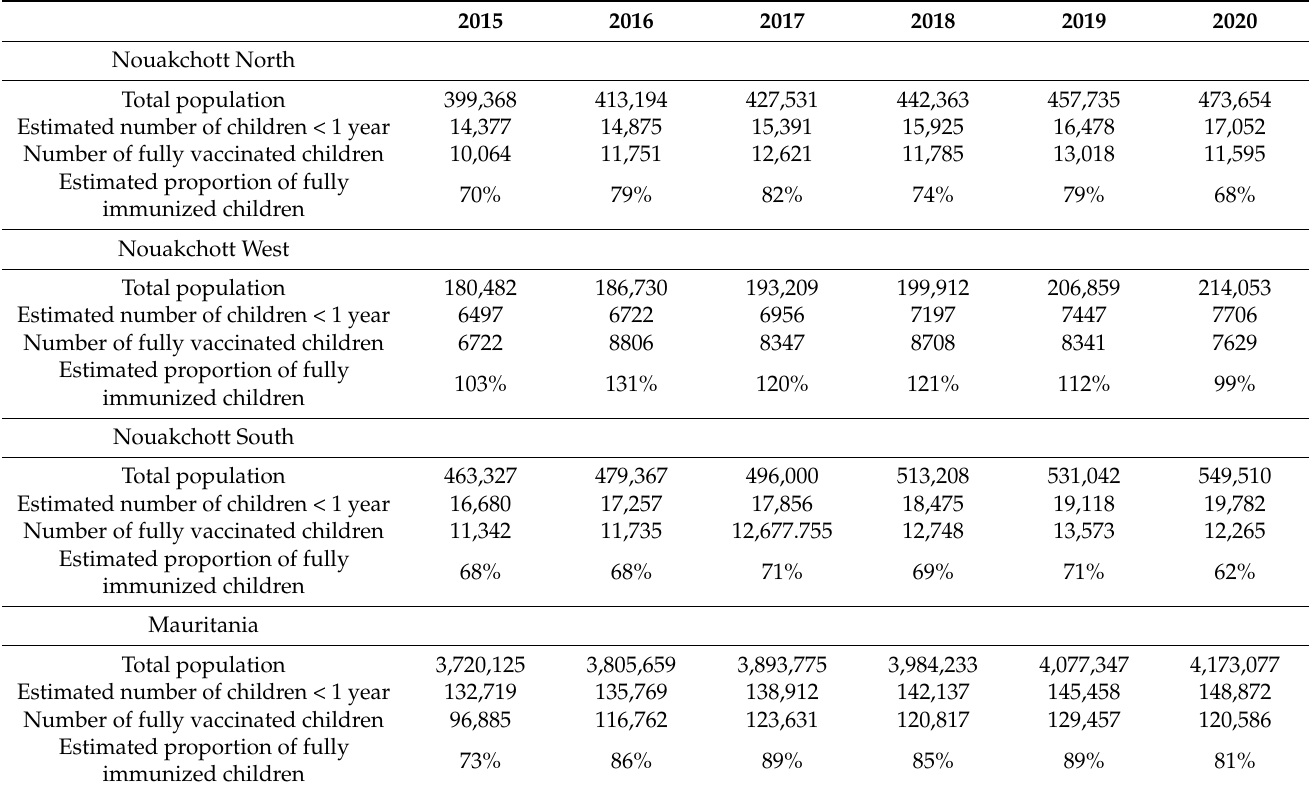
Table 1. Three dose [HepB3] coverage. HBV vaccination coverage in toddlers younger than 1 year old was calculated for the districts of the capital Nouakchott and for the whole of